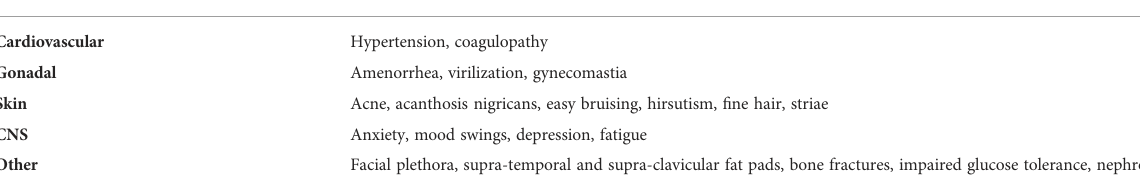
TABLE 1 Phenotypic manifestations of pediatric Cushing